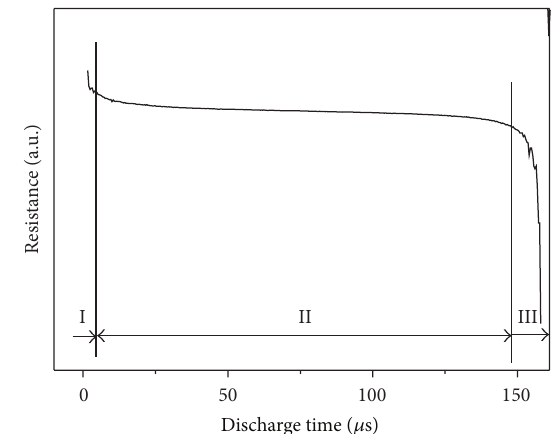
Figure 10: Resistance variation of MAed Ti 5 Si 3 powder column calculated from the voltage and current recordings during an electrical